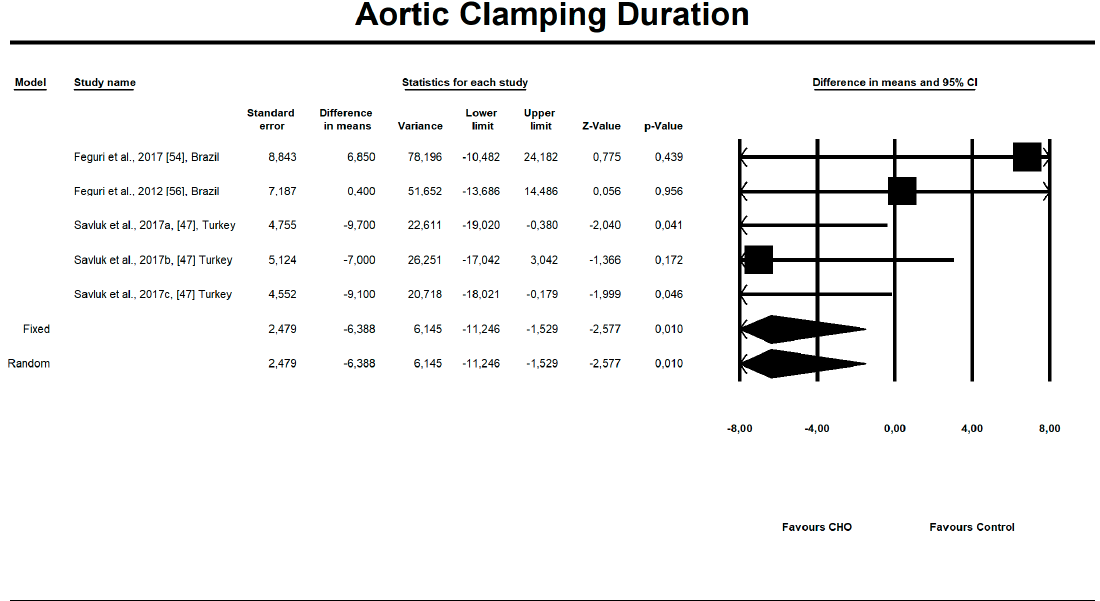
Figure 3. An e ff ect size, di ff erence in means, for aortic clamping (AC) duration (minutes) in patients Figure 3. An effect size, difference in means, for aortic clamping (AC) duration (minutes) in patients taking oral carbohydrates (OCH) drinks vs. controls. 95%Cl—95% confidence taking oral carbohydrates (OCH) drinks vs. controls. 95%Cl – 95% confidence interval.